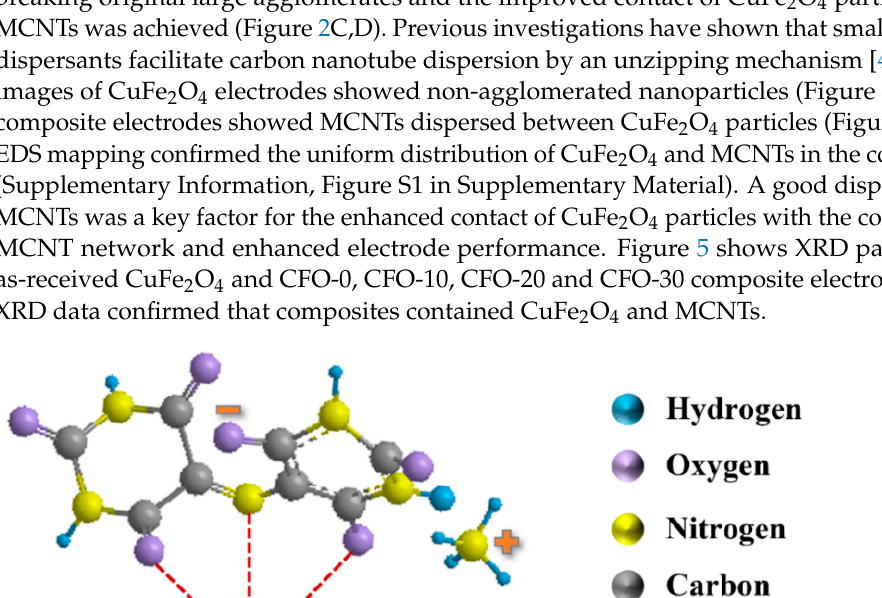
Figure 3. Adsorption of ASPA on CuFe 2 O 4 particles, involving chelation of surface atoms (M = Cu or Fe).